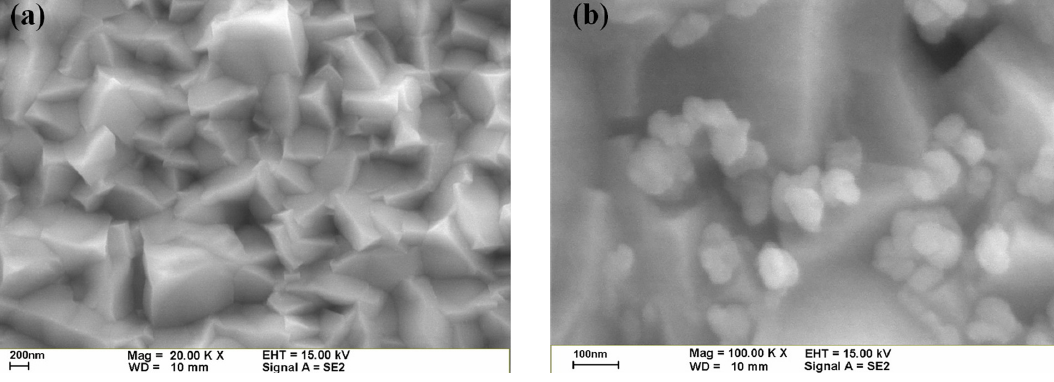
Figure 4. Surface morphology of the Cu plate (a) after the pre-oxidation treatment at 600 °C in N 200 °C in air for 10